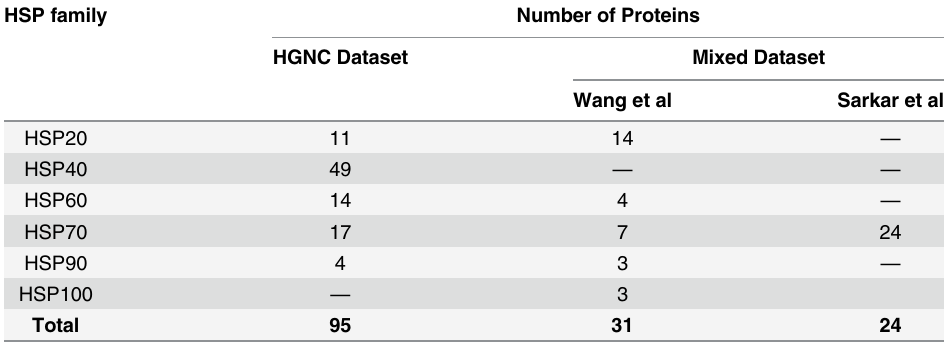
Table 2. Distribution of HSPs across different families in independent datasets. HGNC dataset con- tains human HSPs obtained from HGNC [14] and mixed dataset contains rice HSPs obtained from Wang et al [15] and Sarkar et al